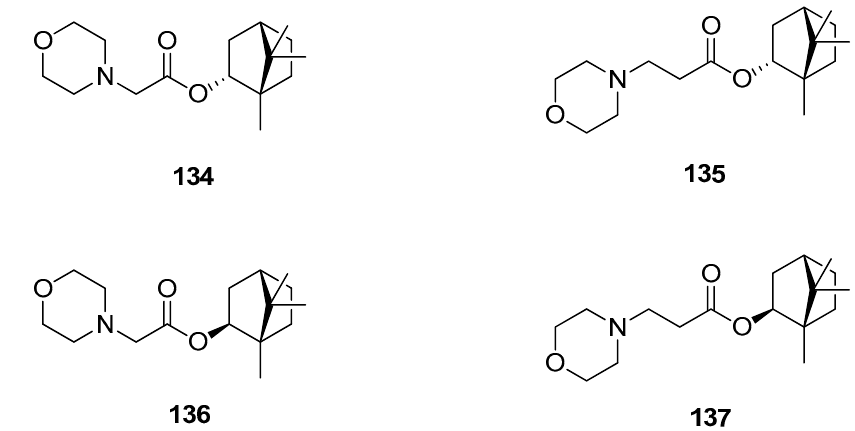
Figure 39. (–)-Borneol and (–)-isoborneol derivatives with morpholine fragment.